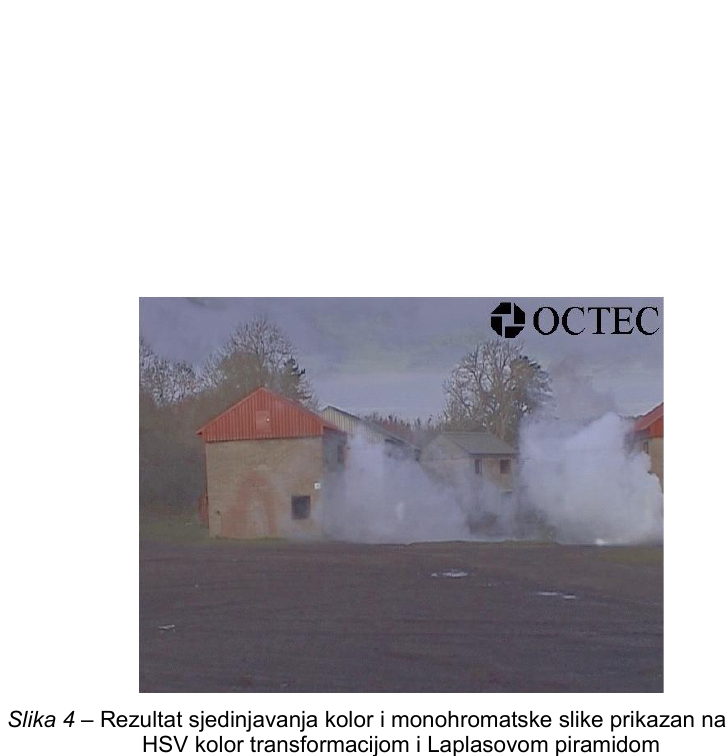
Figure 4 – Colour fusion of the inputs in Figure 1 using the HSV space and the Laplacian pyramid fusion